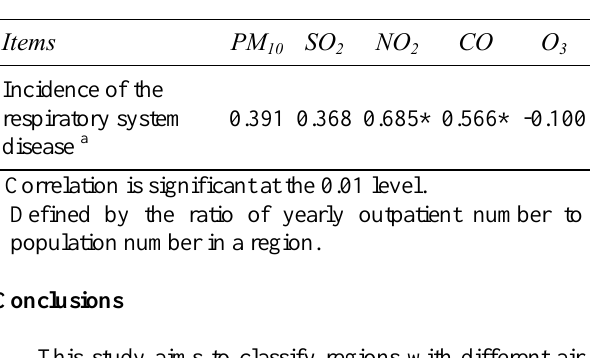
Table 1: Pearson’s correlation coefficients between